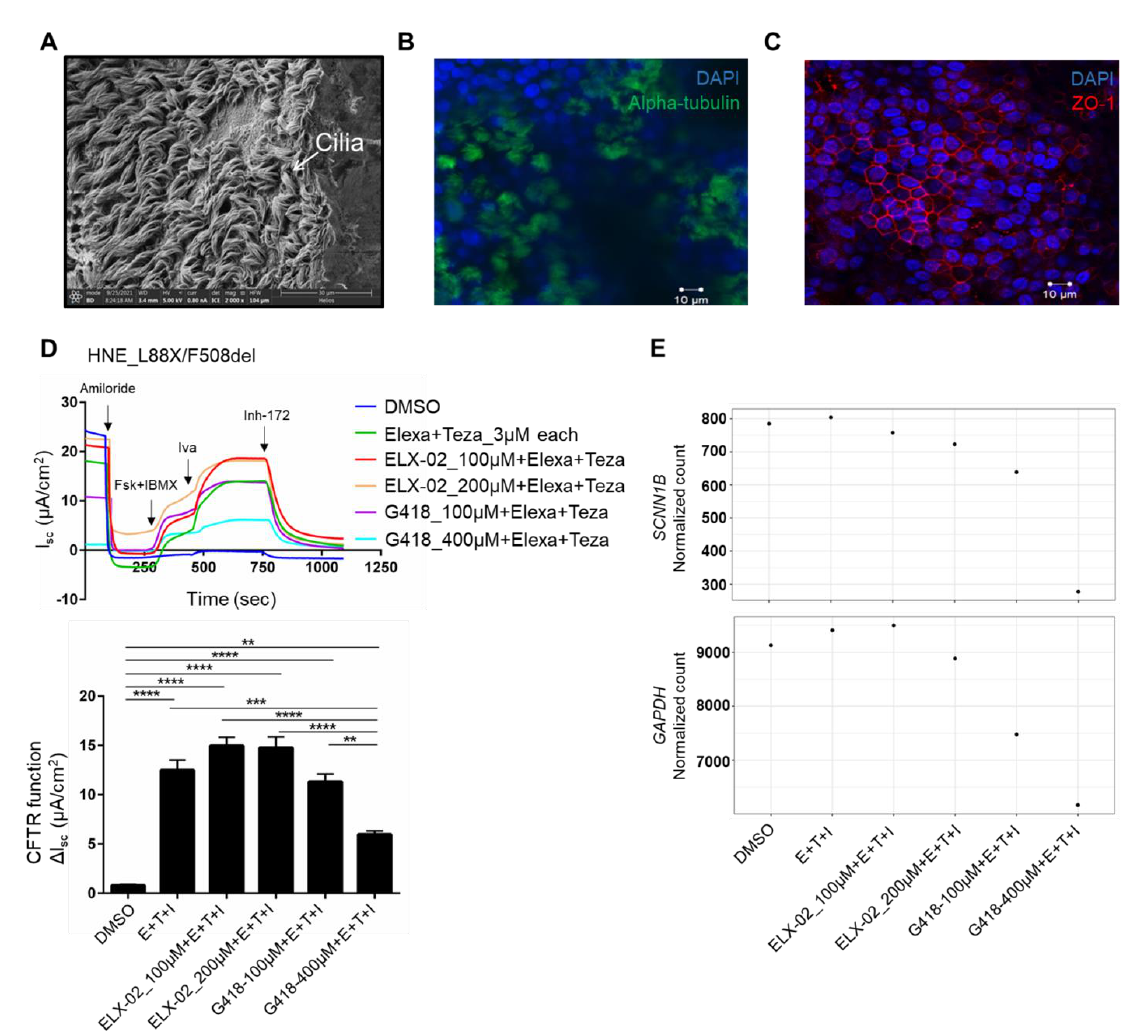
Figure 6. Combination treatment of readthrough G418 or ELX-02 with CFTR modulators restores L88X CFTR function in primary human nasal epithelial cells harboring L88X. ( A ) Scanning electron microscopy of primary human nasal epithelial (NE) cells at air-liquid interface (ALI) culture. NE cells were conditionally reprogrammed using Rho-kinase inhibitor. NE cells were transferred on snapwellls and exposed to air on the apical side to establish ALI culture. ( B ) Confocal microscopy of NE cells following staining of alpha tubulin, a marker of cilia. ( C ) Confocal microscopy of NE cells following staining of ZO-1, a marker of tight junctions. ( D ) Short circuit current (Isc) assay in L88X/F508del NE cells. NE cells were mounted on Ussing chambers to measure CFTR mediated chloride activity as a proxy to CFTR function. Cells were incubated for 24 h with varying concentrations of readthrough compound ELX-02 (100 µM and 200 µM) or G418 (100 µM and 400 µM) and CFTR correctors elexacaftor (3 µM) and tezacaftor (3 µM). Forskolin (10 µM) was added to the basolateral chamber, followed by potentiator ivacaftor (10 µ M) and CFTR inhibitor Inh-172 (10 µ M) added to the apical chamber. Stacked bar plots indicate effect of ELX-02 or G418 readthrough concentration and modulator treatment on L88X/F508del NE cells. Change in Isc ( ∆ Isc) was defined as the current inhibited by Inh-172 after sustained Isc responses achieved upon stimulation with forskolin alone or sequentially with ivacaftor. ** indicates p ≤ 0.01, *** indicates p ≤ 0.001, **** indicates p ≤ 0.0001. ( E ) Bulk RNA-sequencing of L88X/F508del NE cells. Total RNA was extracted from the filters after CFTR functional testing. Each point represents one biological replicate. Top panel shows normalized count of SCNN1B and bottom panel shows normalized count of GAPDH after treatment with ELX-02 (100 µ M and 200 µ M) or G418 (100 µ M and 400 µ M) and CFTR correctors elexacaftor (3 µ M), tezacaftor (3 µ M), and ivacaftor (10 µ